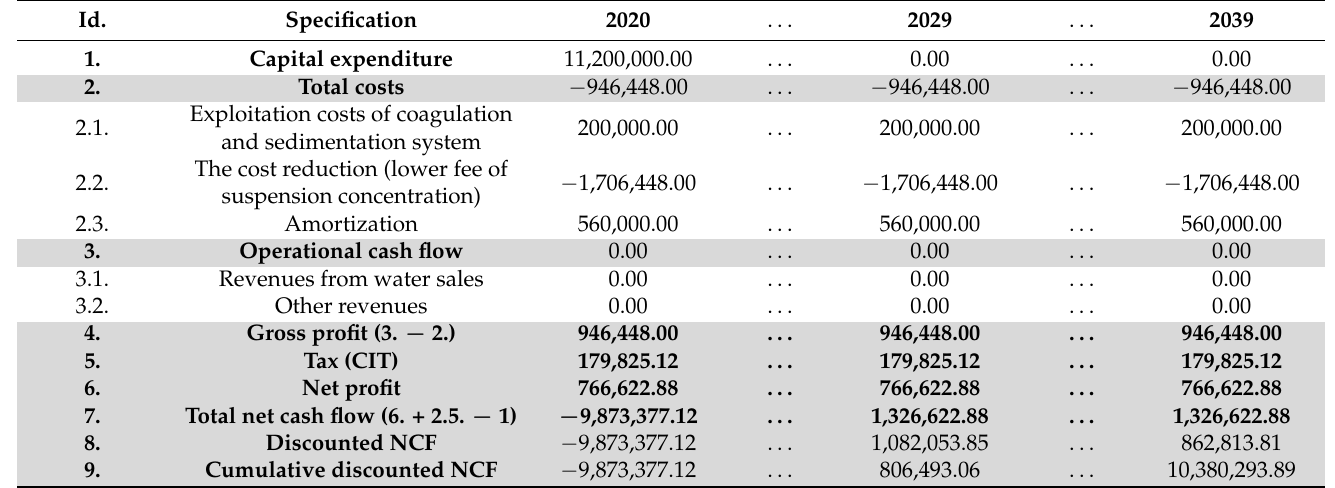
Table 4. Cash flows in Variant 3 (TSS concentration = 200 mg/dm 3